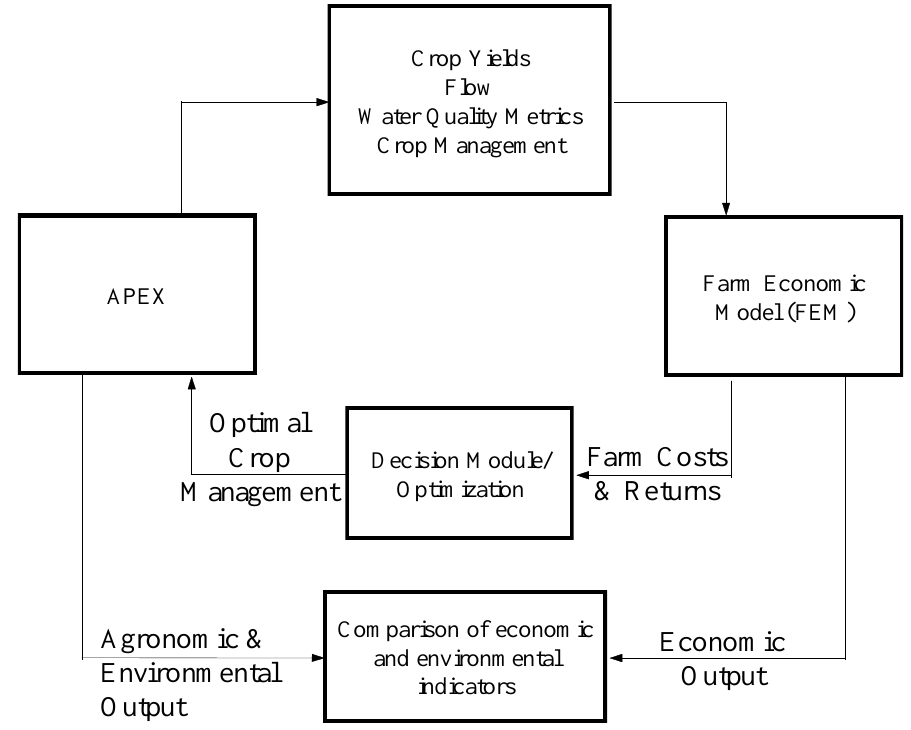
Figure 1. Schematic of FEM and APEX linkage for scenario simulation and analysis.